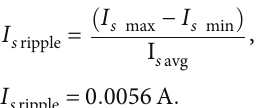
Figure 8: (a) DC supply V based DC microgrid operated with half-bridge BDC in buck